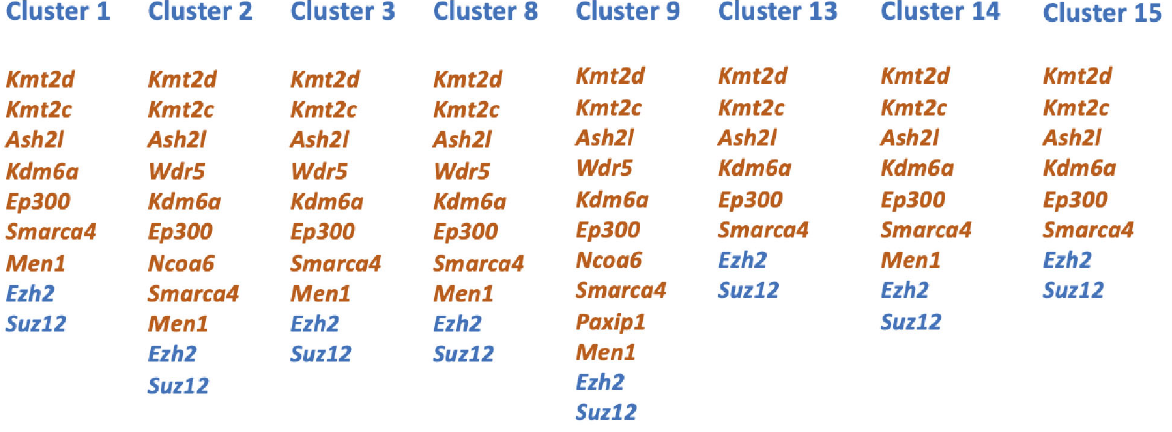
Figure 5: Core set of epigenetic factors that are common in fi ve subpopulations of MSCs, pericytes, Schwann cells, and vascular endothelial cells. These factors are KMT2D, KDM6A, KMT2C, ASH2L, p300, and SMARCA4, which are the key components of the SET1/COMPASS complex (brown), as well as EZH2 and SUZ12 (blue), which are subunits of the PRC2.